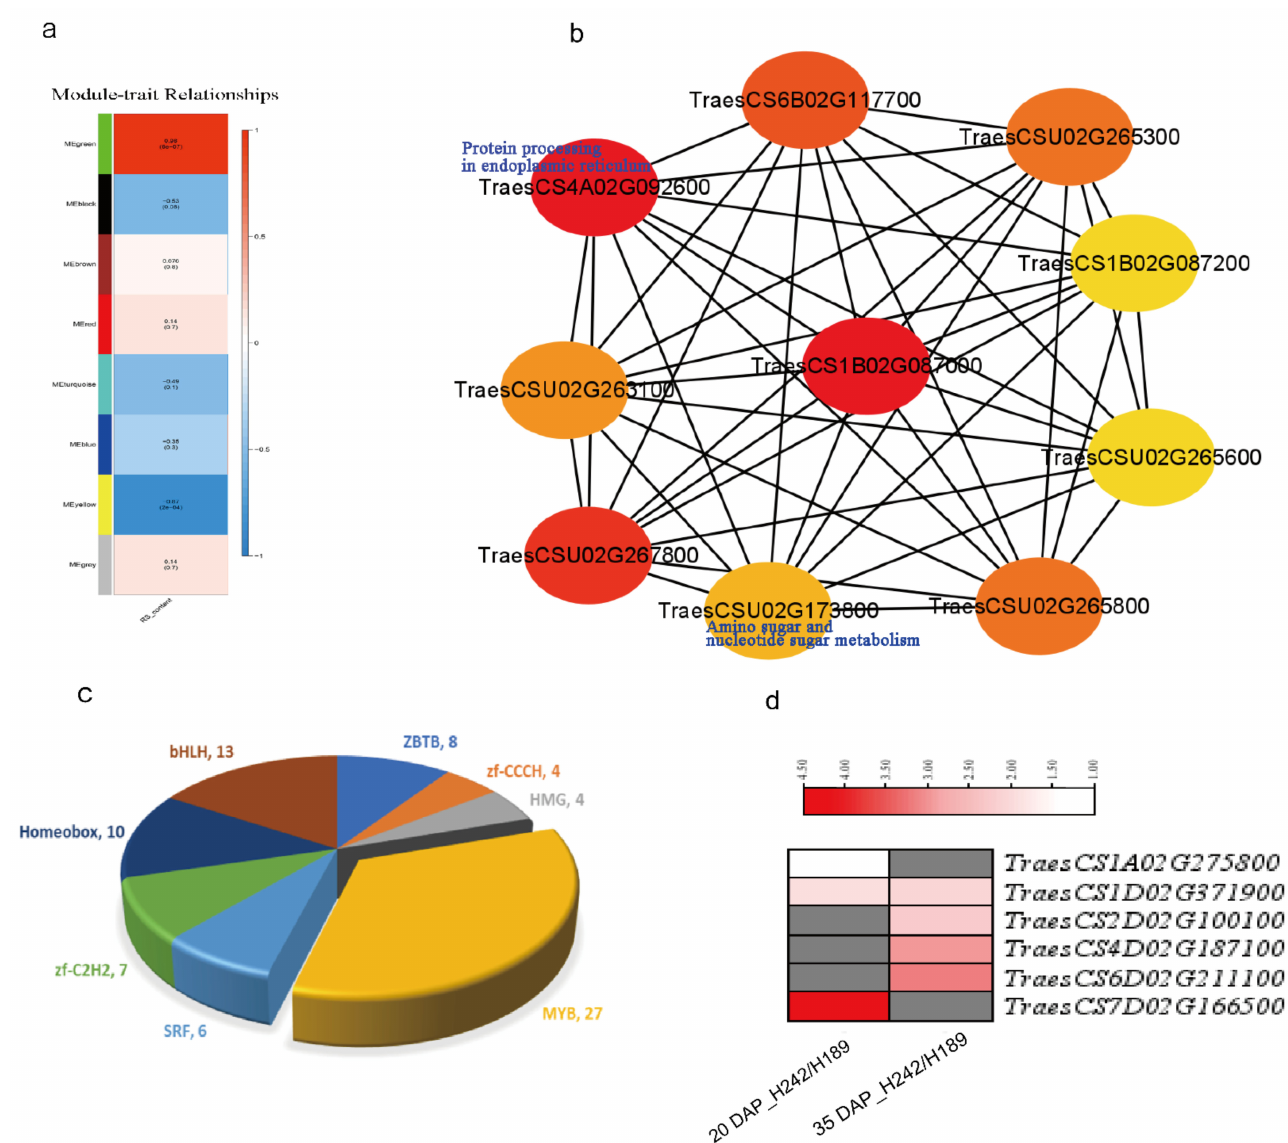
Figure 3. Identification of coexpression network modules related to wheat grain RS content. ( a ) Corre- lation analysis between modules and RS content traits by WGCNA. The colour of each grid indicates the correlation between the module and RS data: red represents a positive correlation, blue represents a negative correlation, and the number in each grid represents the correlation coefficient and the p value. ( b ) Gene network of the green module, which is positively correlated with RS contents (r 2 = 0.96). Redder colour of circles indicates higher degrees of connectivity in each module. ( c ) Classification and number of transcription factors (TFs). ( d ) Heatmap of DEGs encoding members of MYB family. Grey means no differential